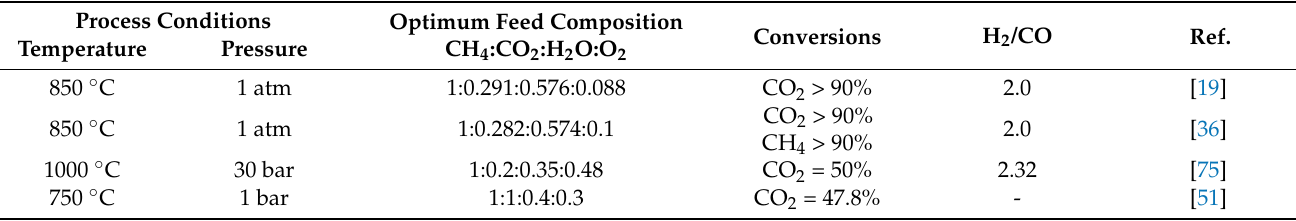
Table 4. Optimum process